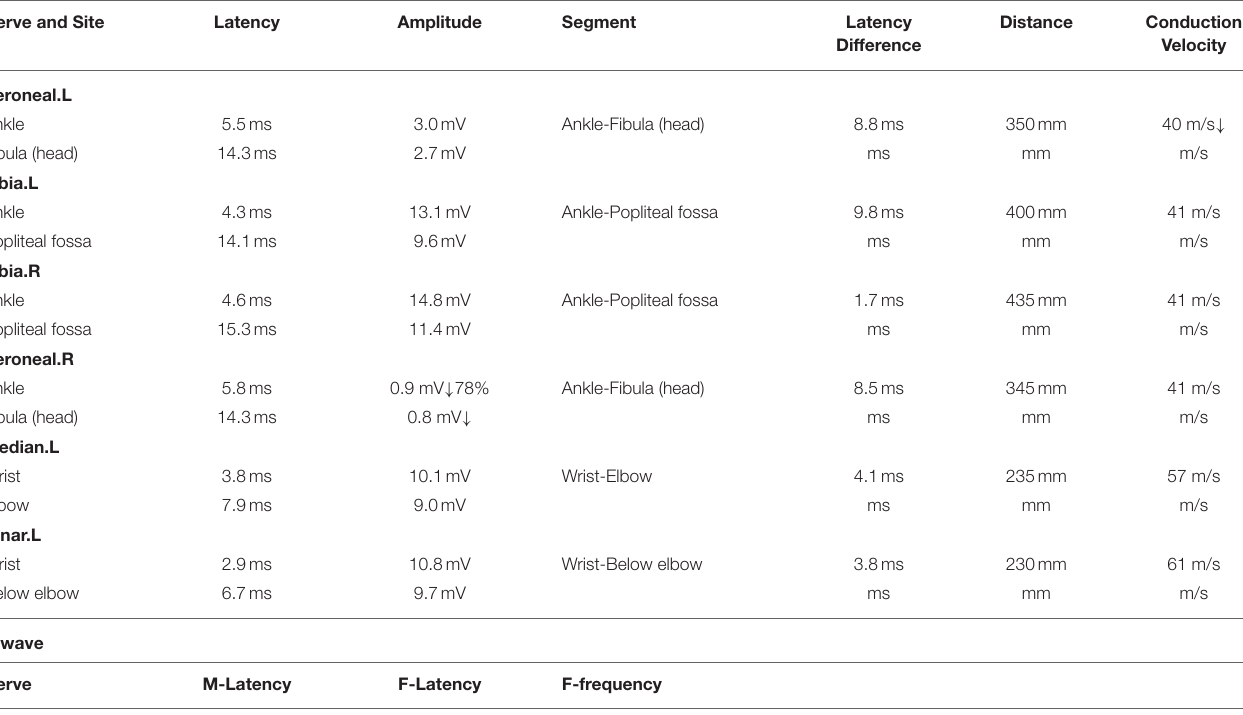
TABLE 2 | Electromyography. Motor nerve Conduction Velocity (MCV) Nerve and Site